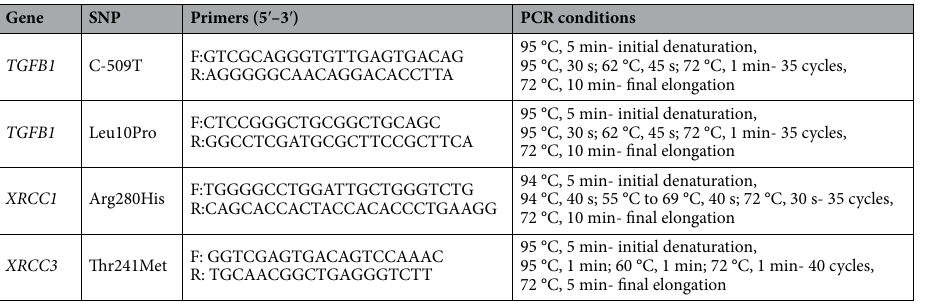
Table 7. Primers’ sequences and PCR